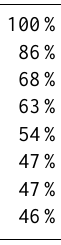
Table 1. Decreasing FDC variance (layer-by-layer down the